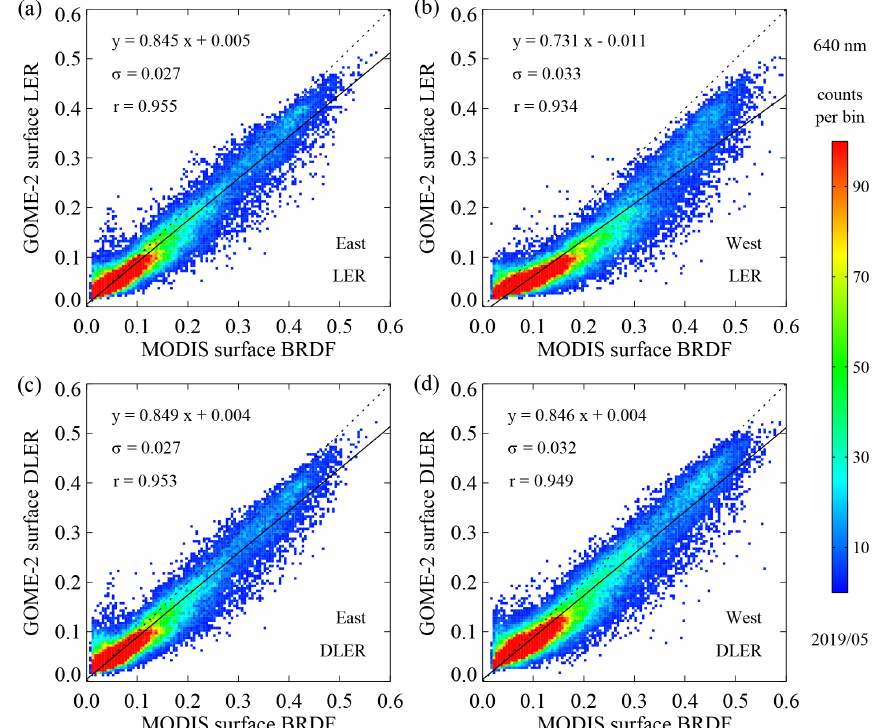
Figure 9. Global comparisons between GOME-2 surface (D)LER and MODIS surface BRDF for the period 10–19 May 2019. (a, b) GOME- 2 non-directional surface LER at 640nm versus MODIS surface BRDF from band 1 (centred around 645nm) for eastern and western sides of the orbit swath (see main text). (c, d) GOME-2 directional surface DLER versus MODIS surface BRDF. For the western side of the orbit swath the directional database agrees much better with MODIS than the non-directional